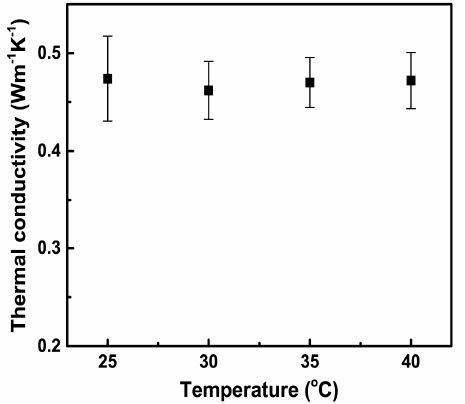
Figure 4. Temperature dependent thermal conductivity of PAAm hydrogels with crosslinker amount of 0.099 mol % measured by the 3 ω method.